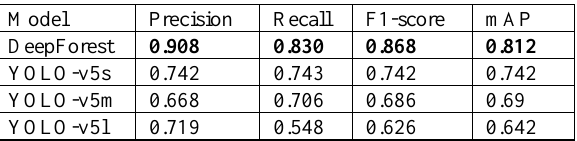
Table 2 . Metrics associated with each model. Values in bold font correspond to the best achieved performance.